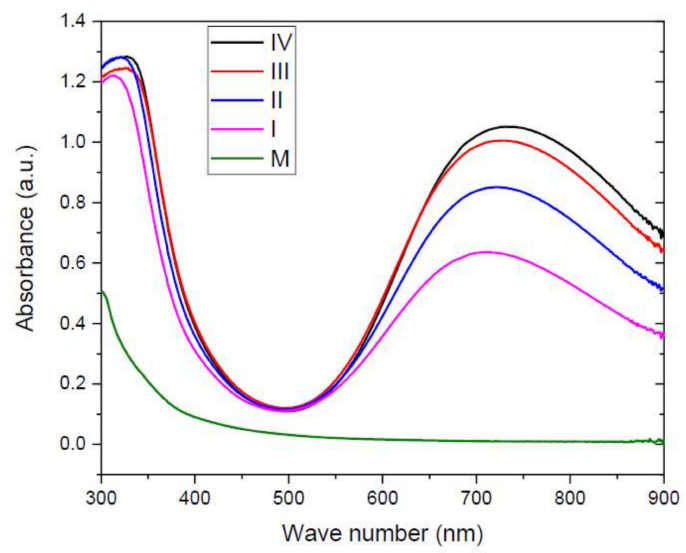
Figure 9. UV-VIS absorption spectra of hydrogel samples (M, I, II, III,